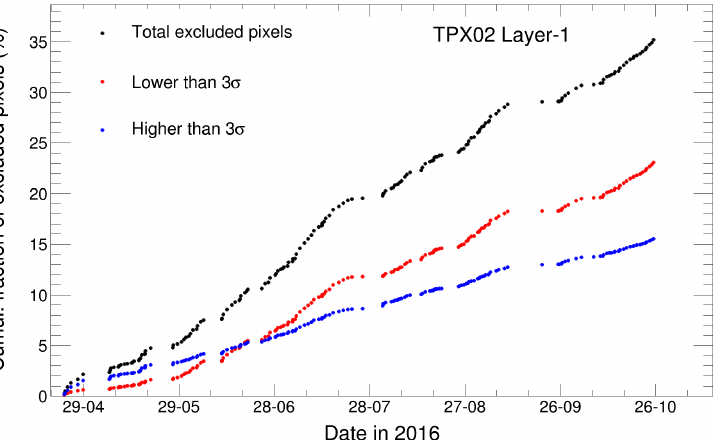
Figure 51. Cumulated fraction of excluded pixels for device TPX02 layer 1 as a function of time. The cumulated fractions of pixels with a rate below 3 σ are shown in red, whereas the cumulated fractions of pixels with a rate above 3 σ are shown in blue. Taken from Ref.